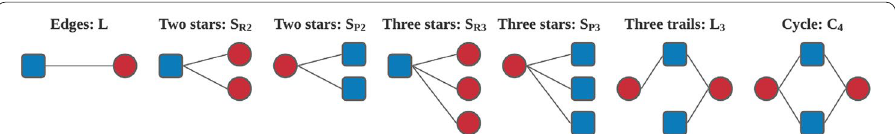
Fig. 2 Seven network configurations of bipartite networks: R and P represent two node sets of bipartite networks (Roster actors and Participants respectively in this study); blue squares represent node set R; red circles represent node set P